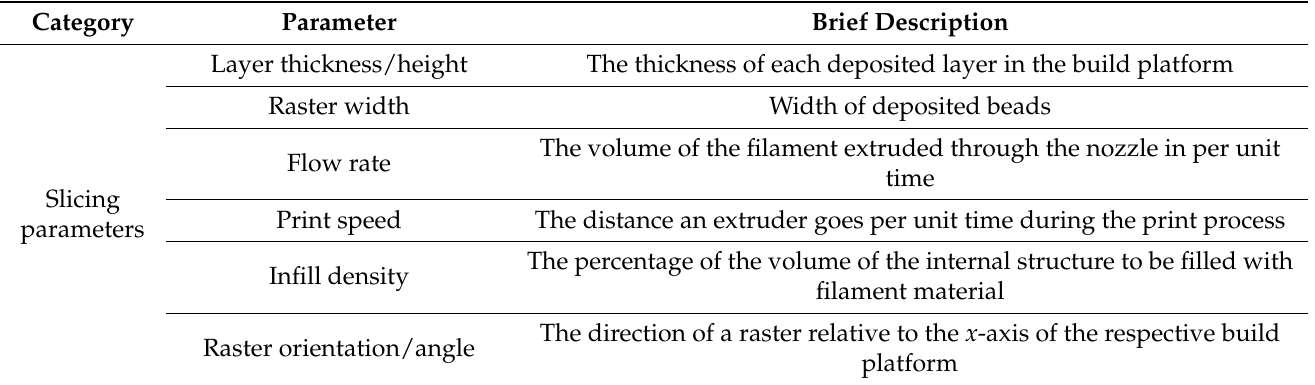
Table 1. Fused filament fabrication (FFF) process